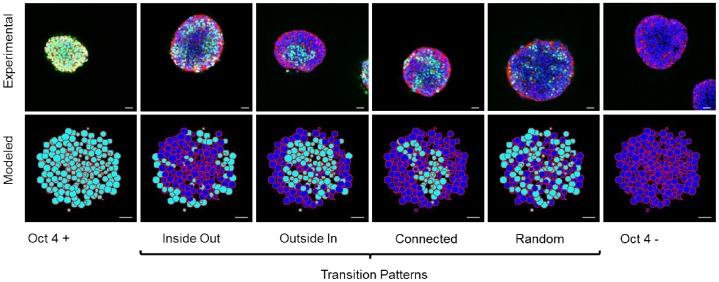
Classification of differentiation spatial patterns within EBs.Six classifications are used to described Oct4 expression patterns: undifferentiated, inside-out, outside-in, connected, random, and differentiated. Confocal images shown on top are stained with DAPI (blue), phalloidin (red) and Oct4 (green) (with a scale bar of 25 µm). The model generates patterns similar to confocal images with Oct4− cells (dark blue) and Oct4+ cells (cyan). Scale bar represents 25 µm.